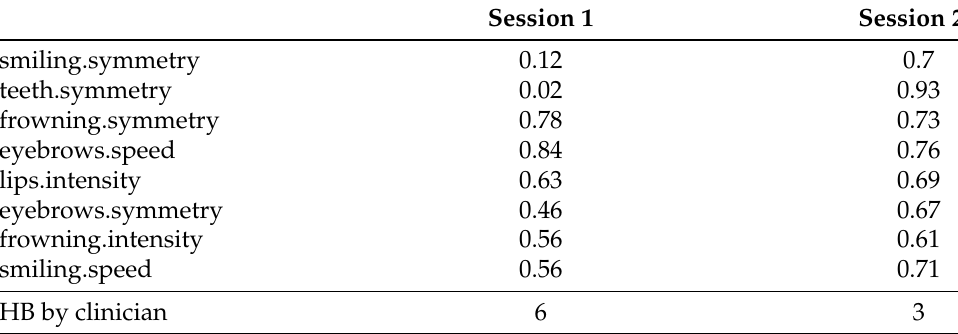
Table 12. Health scores for two sessions with the typical